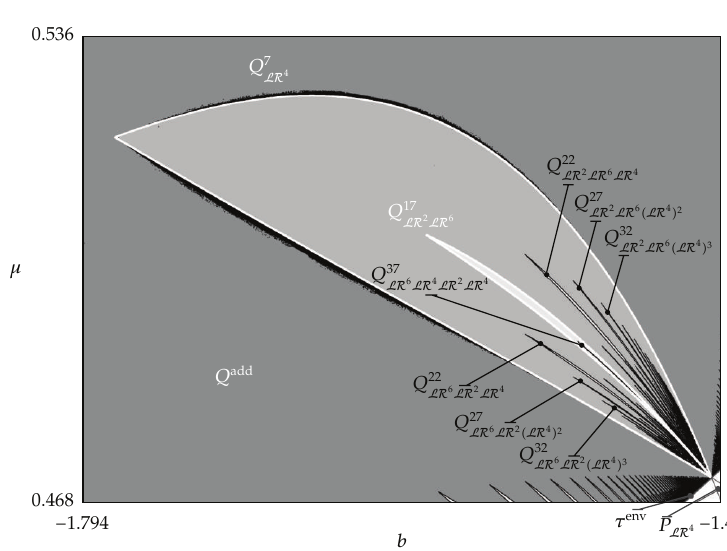
Figure 10: Numerically calculated bandcount diagram in the 2D parameter space for a (cid:6) 0 . 2, b (cid:6) − 1 . 794 ··· − 1 . 49, μ (cid:6) 0 . 468 ··· 0 . 536. The bandcount-adding region Q 7 LR 4 is shown enlarged. The bandcount is visible in the middle. The first three regions of both nested bandcount-adding doubling region Q 17 LR 2 LR 6 structures to the left and to the right of Q 17 LR are labeled. The second bandcount doubling region 2 LR 6 Q 37 LR 6 LR 4 LR 2 LR 4 is also labeled. The rectangle in Figure 8 shows where this figure is located in the overall bandcount-adding scenario. The analytical Figure 11 corresponds to this